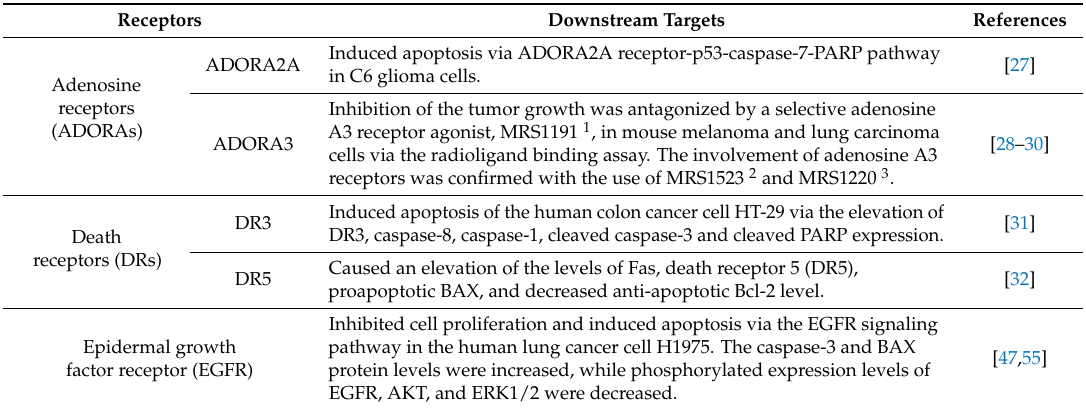
Table 2. Putative receptors stimulated by cordycepin and their downstream